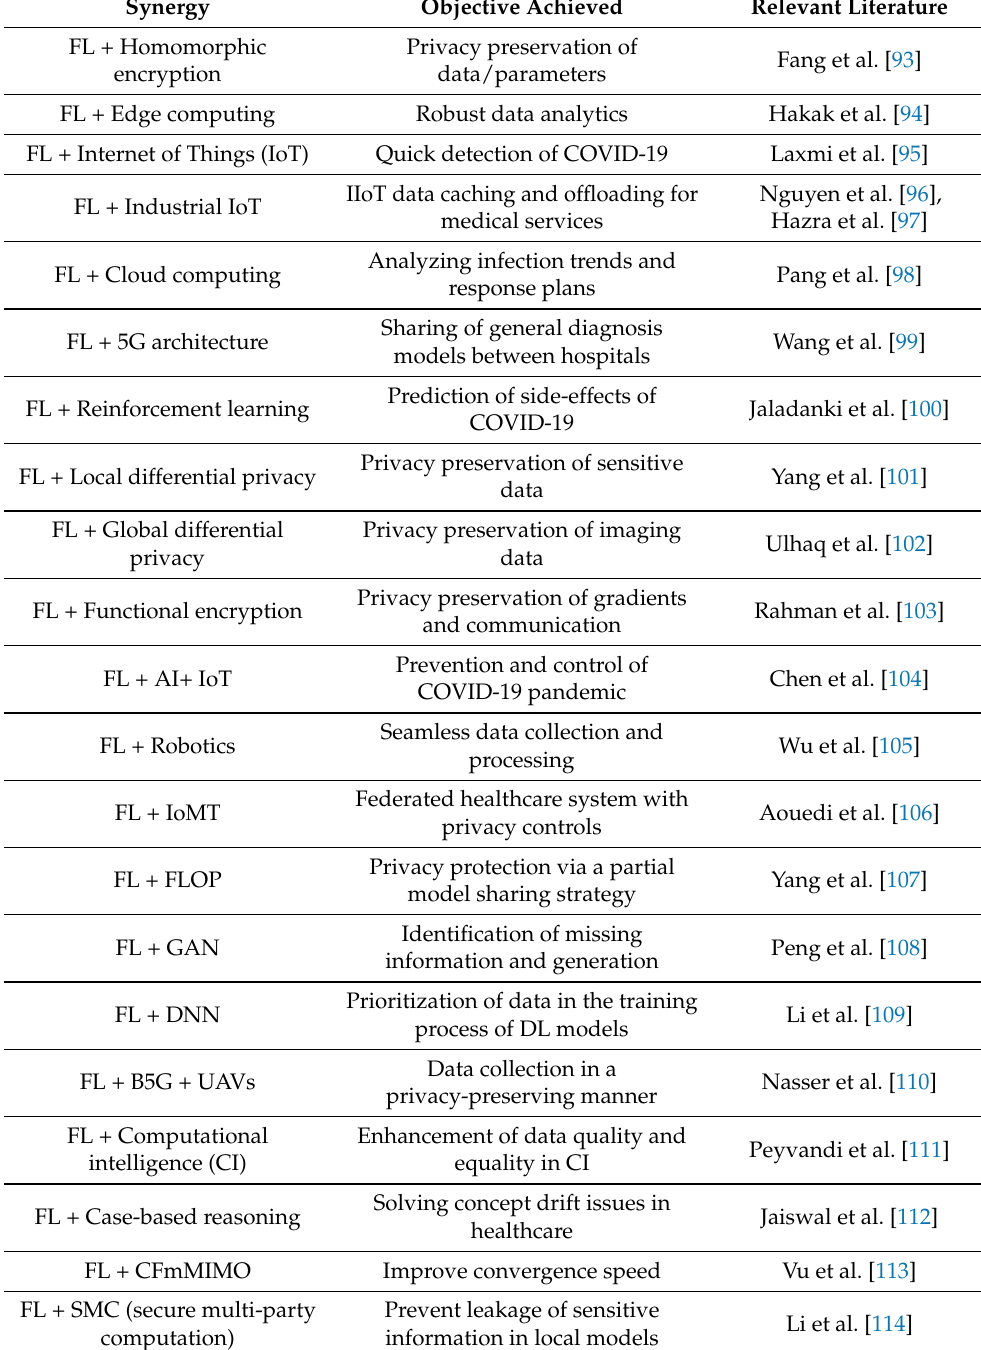
Table 3. Synergy of FL with other emerging